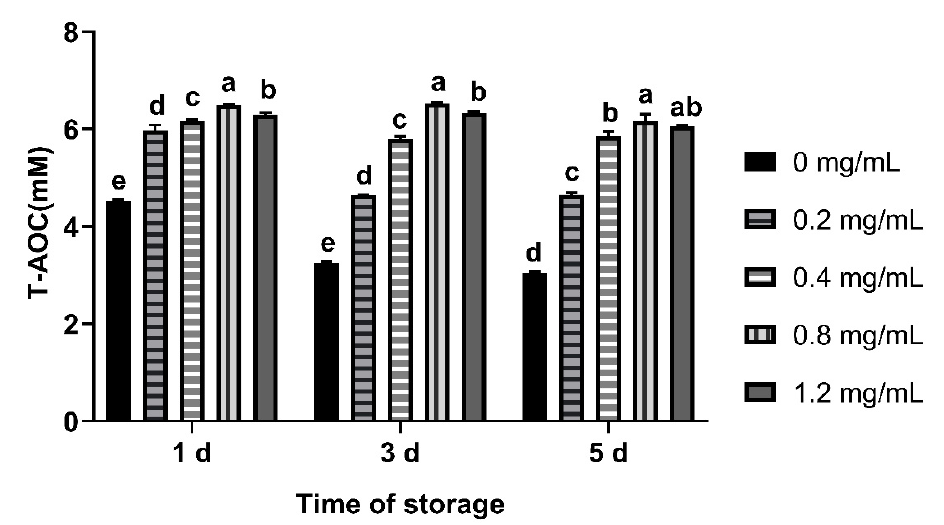
Figure 3. Effects of CGA with different concentrations on T-AOC of chilled ram semen. Note: Different letters above the column indicate significant difference, the same or containing the same letter indicate insignificant difference.